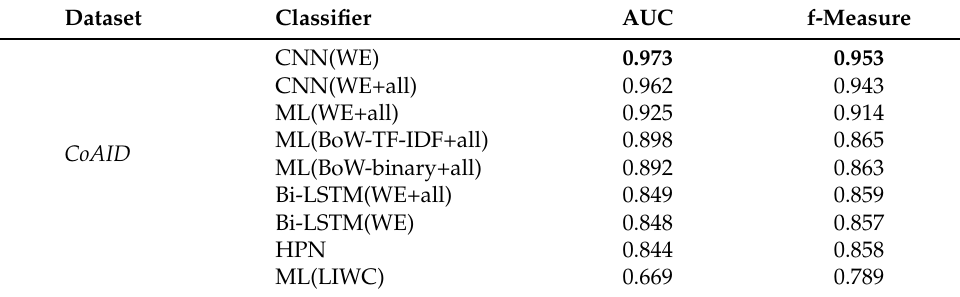
Table 4. Global evaluation results for the CoAID dataset.